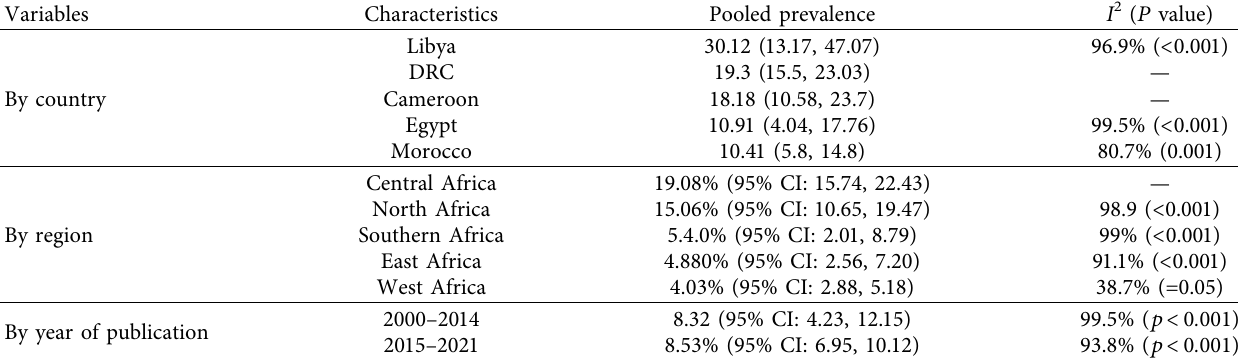
Table 2: Subgroup analysis on the pooled proportion and patterns of chromosomal disorders among births with congenital anomalies: by country, region, and year of publication in Africa from January, 2000 to October, 2021.